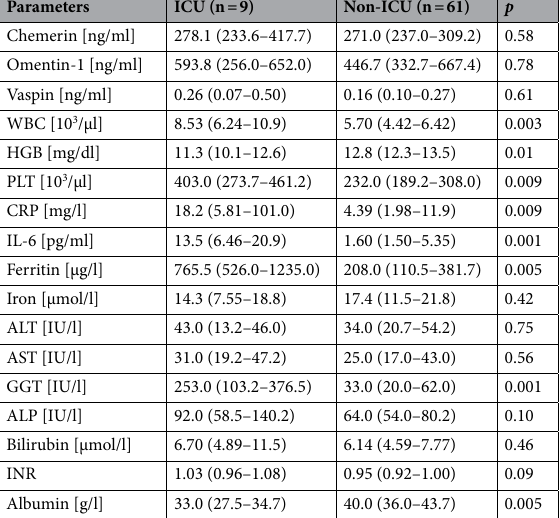
Table 7. Comparison of analyzed parameters between patients requiring and non-requiring ICU.